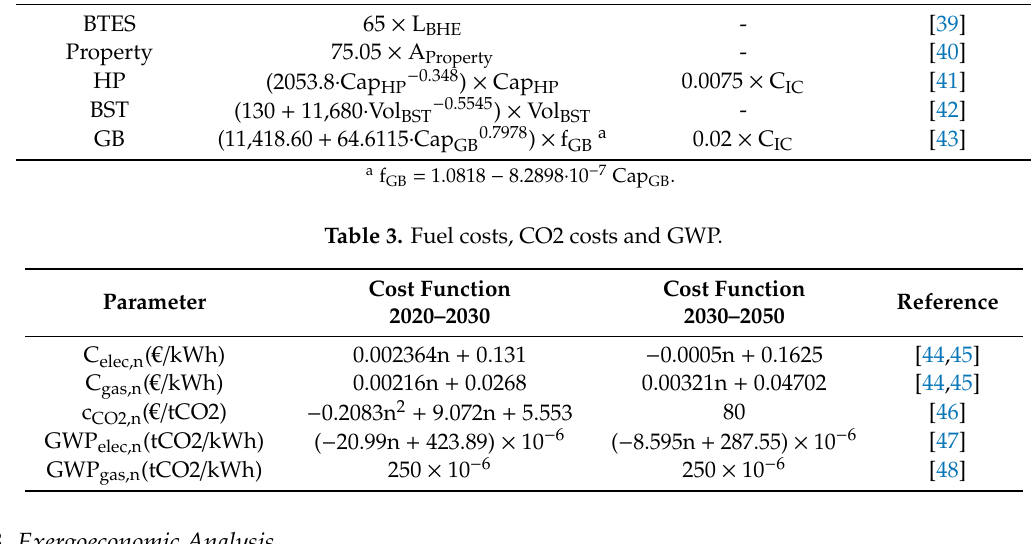
Table 2. After summing up electricity consumptions (f elec ) as well as gas consumptions (f gas ) in each time step over the system lifetime for each simulation, fuel and environmental costs are calculated using Equations (8) and (9). Electricity and gas costs (c elec and c gas ), Global Warming Potential as a result of the consumption of electricity and gas (GWP elec and GWP gas ) and the emission costs (c CO2 ) as a function of the assessment year are calculated as given in Table 3.